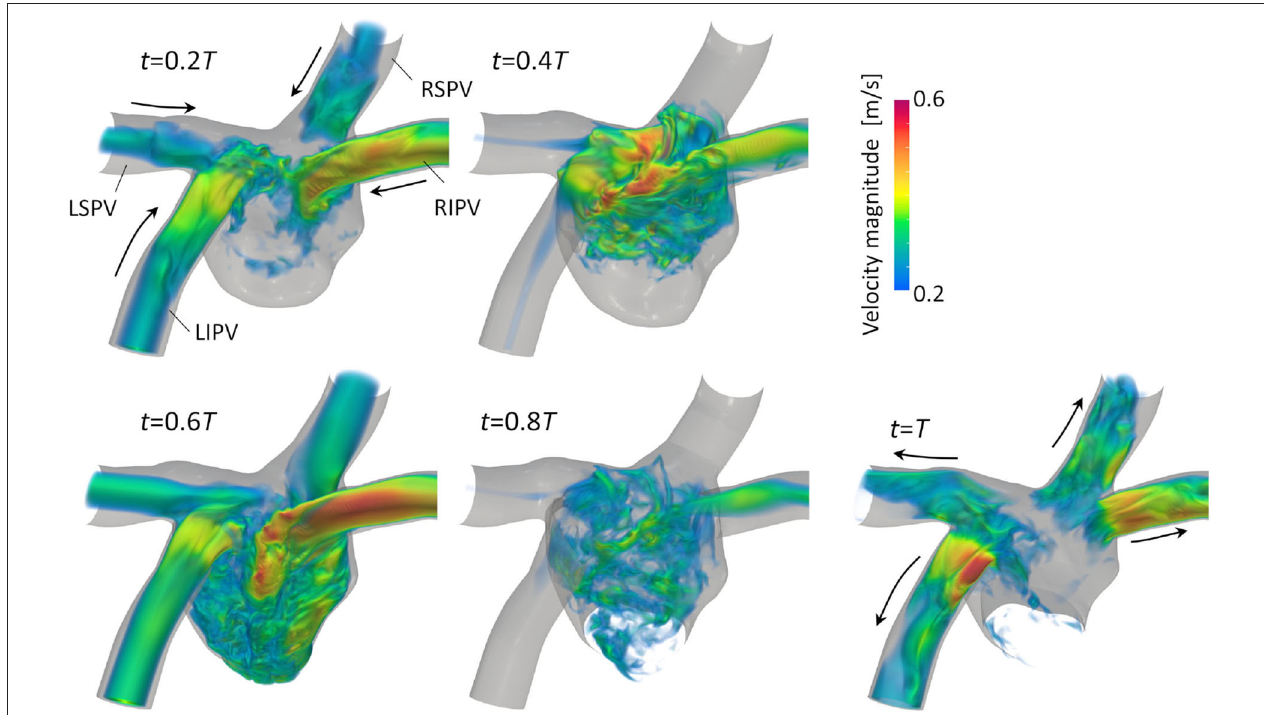
FIGURE 3 | Posterior views of the velocity distribution with volume rendering at t = 0.2 T , 0.4 T , 0.6 T , 0.8 T , and T before upper-left lobectomies ( T : cardiac cycle from the start of systole). Refer to Supplementary Video 1 to see the velocity transition for a whole cardiac cycle.